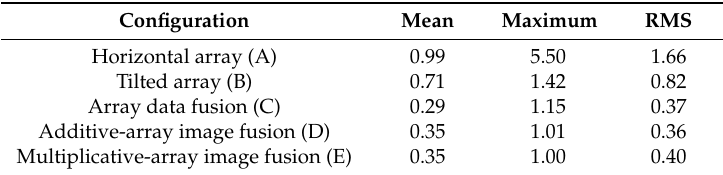
Table 1. Localization error indicators in meters: narrow band source.